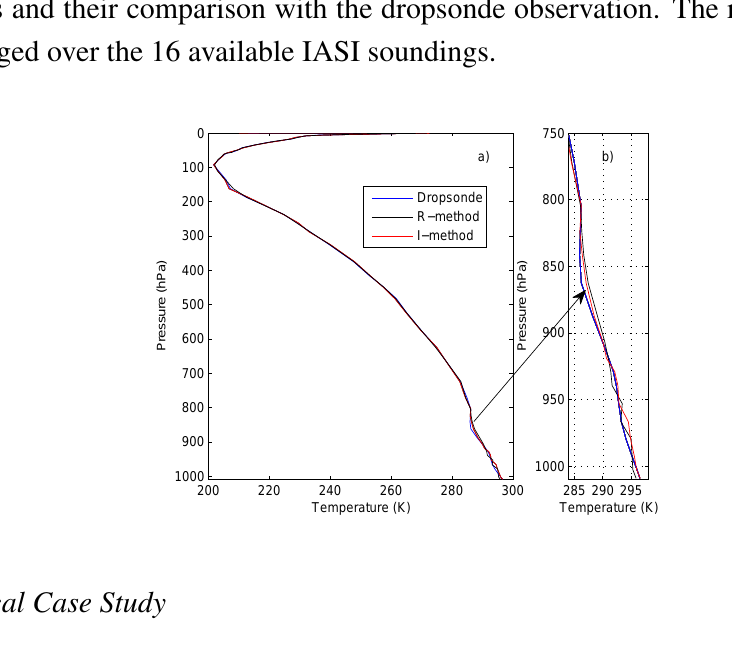
= 0 . 8 cm). Day 30 t